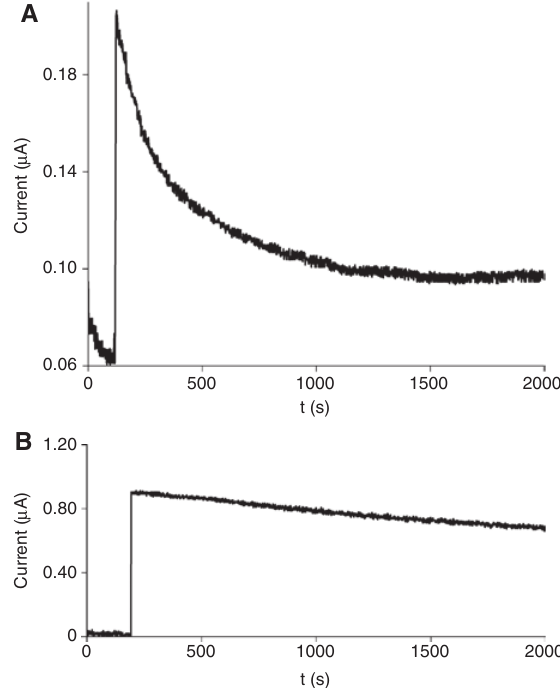
Figure 7: Amperometric response of a bare glassy carbon electrode (A) and the oxidised NAD + /multiwalled carbon nanotube/ionic liquid-modified glassy carbon electrode (B) to a solution of NADH over 1800